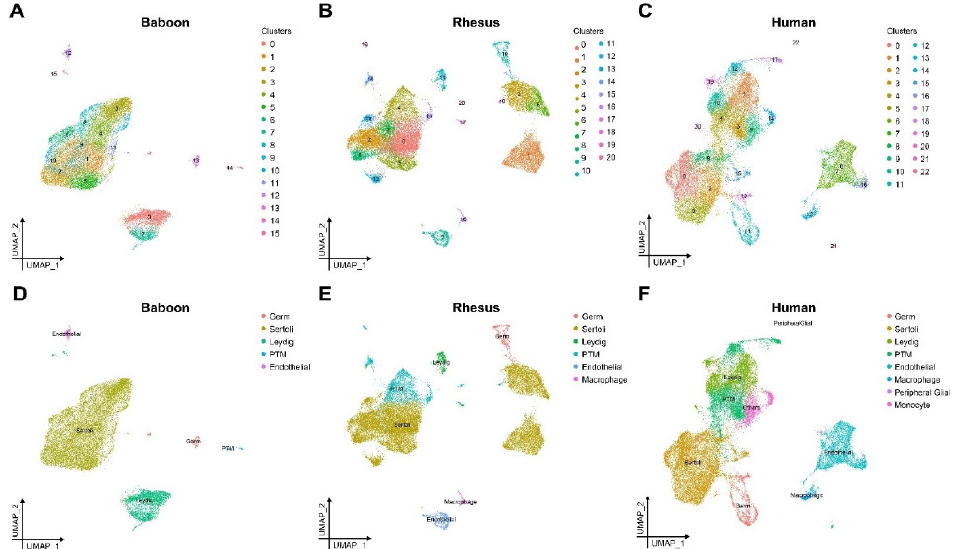
Figure 1. Single-cell RNA-seq analyses of testis cells from prepubertal baboons, rhesus macaques, and humans identify major germ and somatic cell types. ( A – C ) UMAP projections of single-cell transcriptomes from the testes of prepubertal ( A ) baboons ( n = 2), ( B ) rhesus macaques ( n = 2), and ( C ) humans ( n = 6). Each dot represents a single cell and is colored according to unbiased cluster annotation (16 baboon clusters, 21 rhesus macaque clusters, and 23 human clusters). ( D – F ) UMAP projections showing testicular cells, colored by cell types as determined by differential gene expression, to represent germ and somatic cell types (see Figure S1).